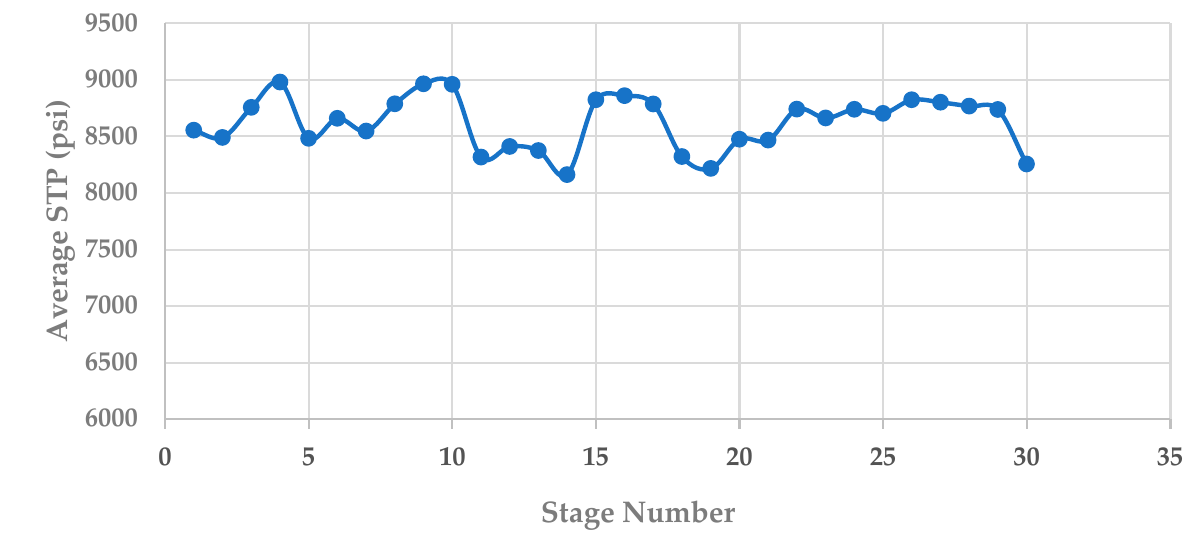
Figure 4. Plot showing trend in average STP for well 1.